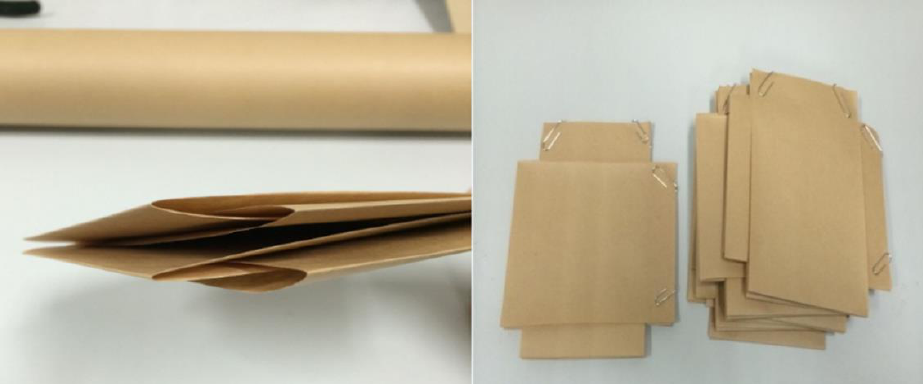
Figure 1. Overlapping cellulose polymer laminates.